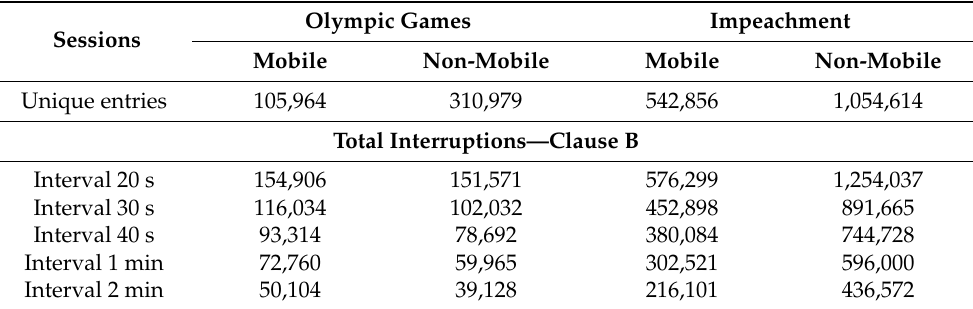
Table 1. Total session interruptions, considering Clause B with different time intervals.